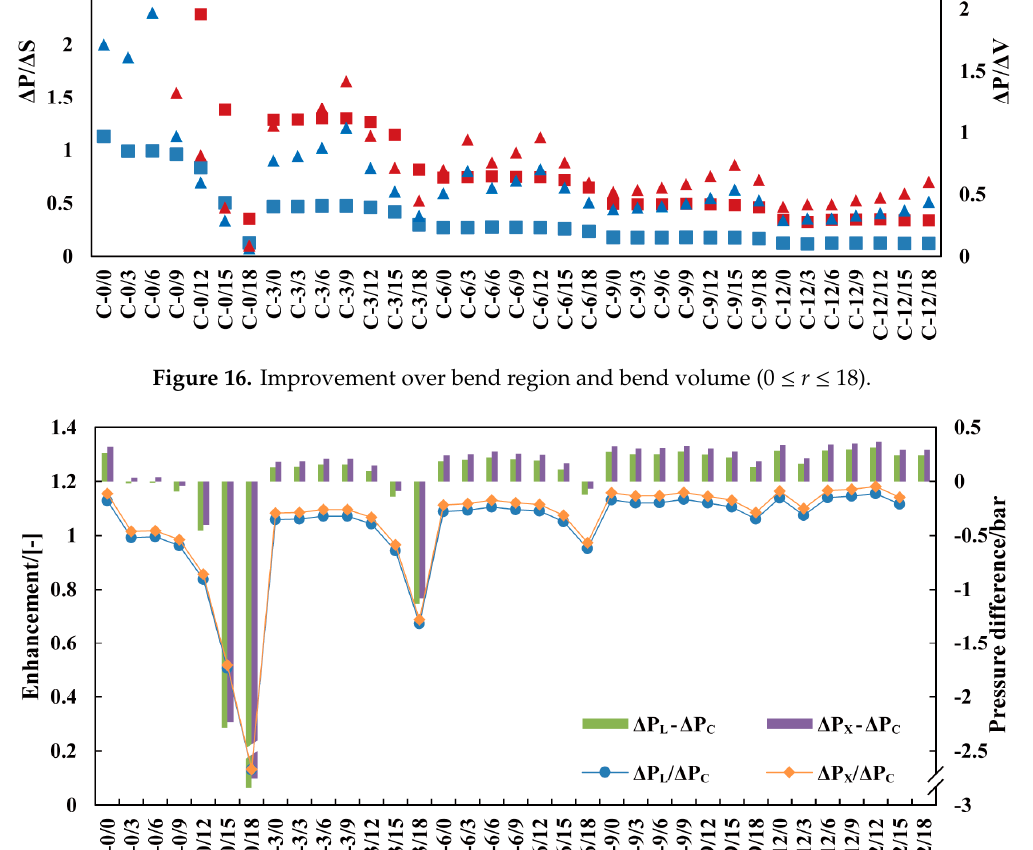
Figure 17. Improvement for C- r i / r o compared to I-X and I-L (0 ≤ r ≤